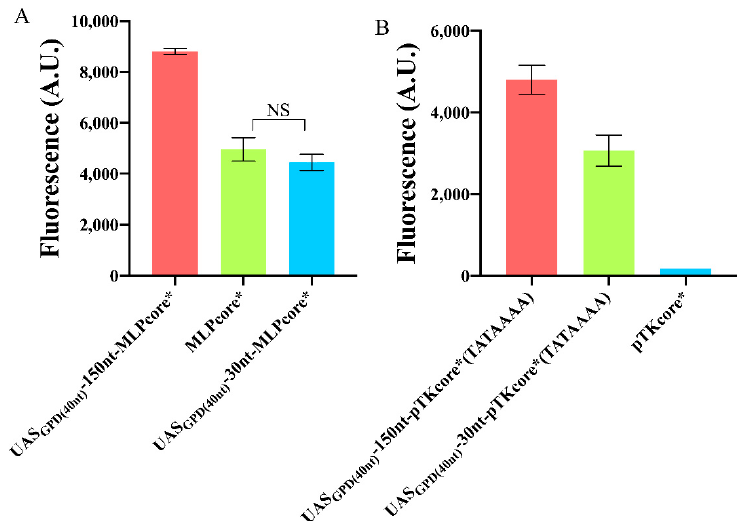
Figure 6. Variation in the fluorescence level of foreign promoters upon addition of an UAS. ( A ) A 150 nt spacer between UAS GPD(40nt) and MLPcore* drastically improved fluorescence expression, whereas a 30 nt spacer had no significant effects (NS: p -value = 0.1961, two-sided Welch’s t -test). ( B ) The weak pTKcore*, modified with the strong TATA box—TATAAAA, underwent dramatic enhancement in fluorescence expression by placing UAS GPD(40nt) both 30 and 150 nt upstream of the TATA box. Each mean fluorescence value comes from three independent experiments, NS: No significant statistical difference.